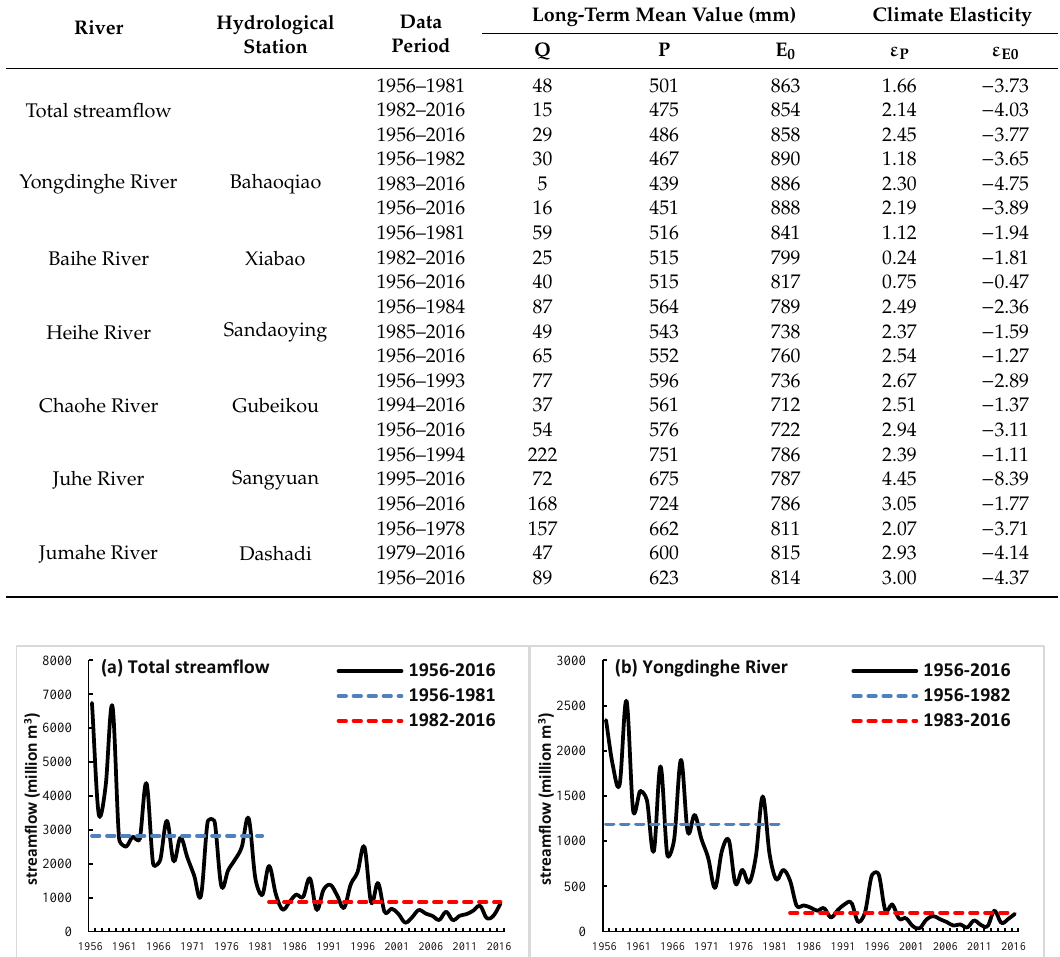
Table 2. Streamflow depth, precipitation, potential evapotranspiration, and climate elasticity over the different